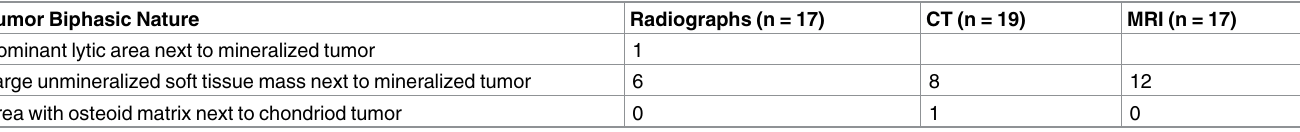
Table 2. Evidence of tumor biphasic